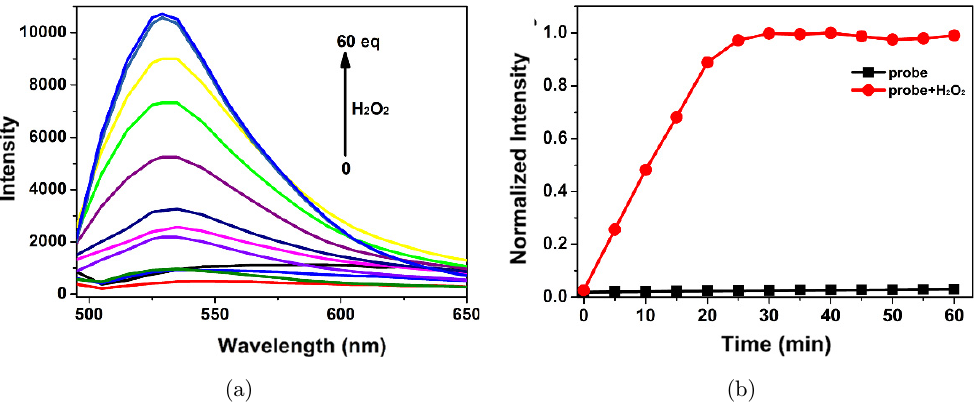
Fig. 1. (a) Fluorescence spectra of CBH in PBS bu®er solution in the presence of H 2 O 2 at di®erent concentrations. (b) Time- dependent °uorescence intensity of CBH upon addition of 10 equiv. H 2 O 2 in PBS bu®er solution.